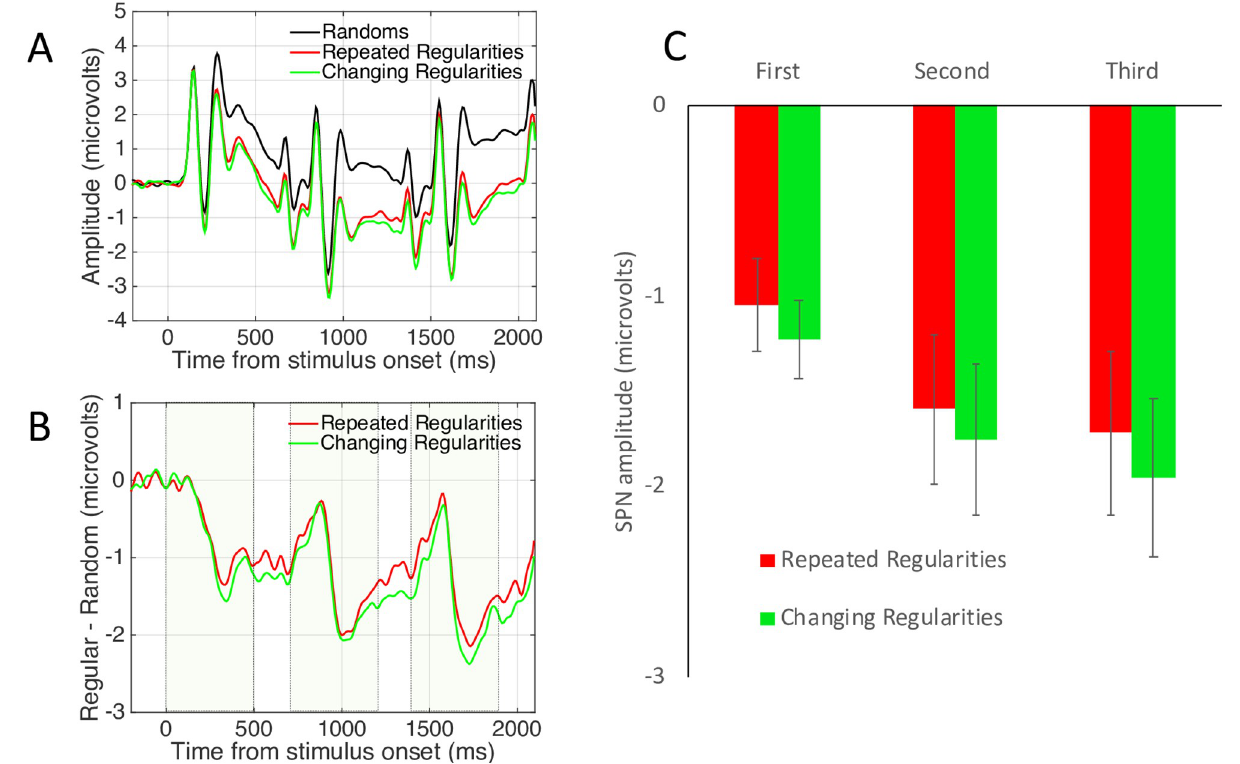
Fig 13. Experiment 5 results. Note SPN priming in both repeated and changing regularity conditions.